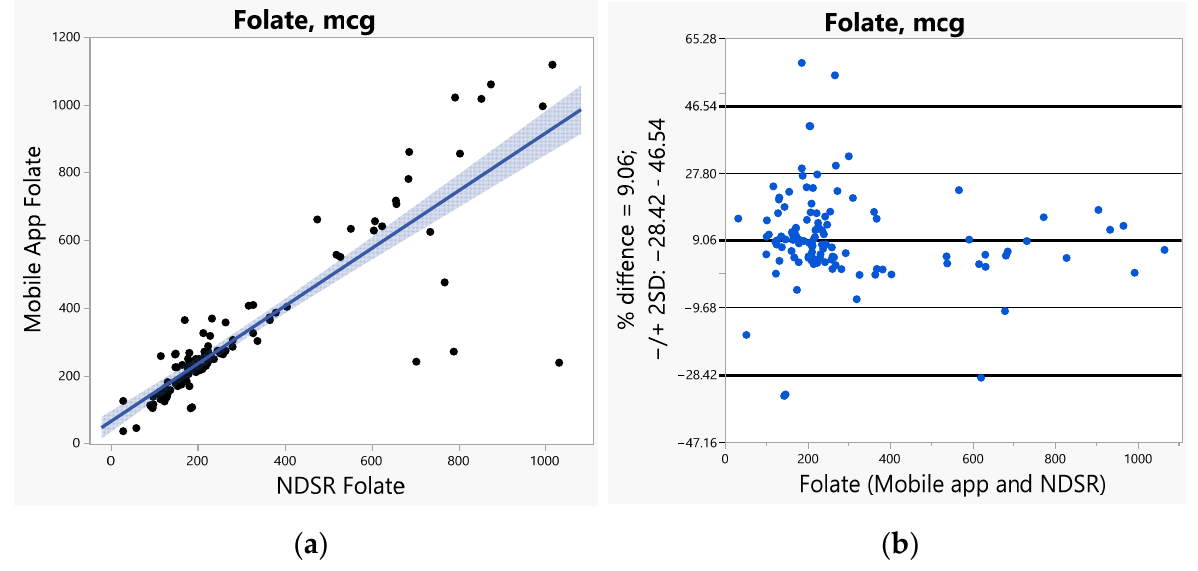
Figure 3. ( a ) Correlation, ( b ) Bland-Altman plots between the internet-based application and Nutri- tion Data System for Research (NDSR) on folate.